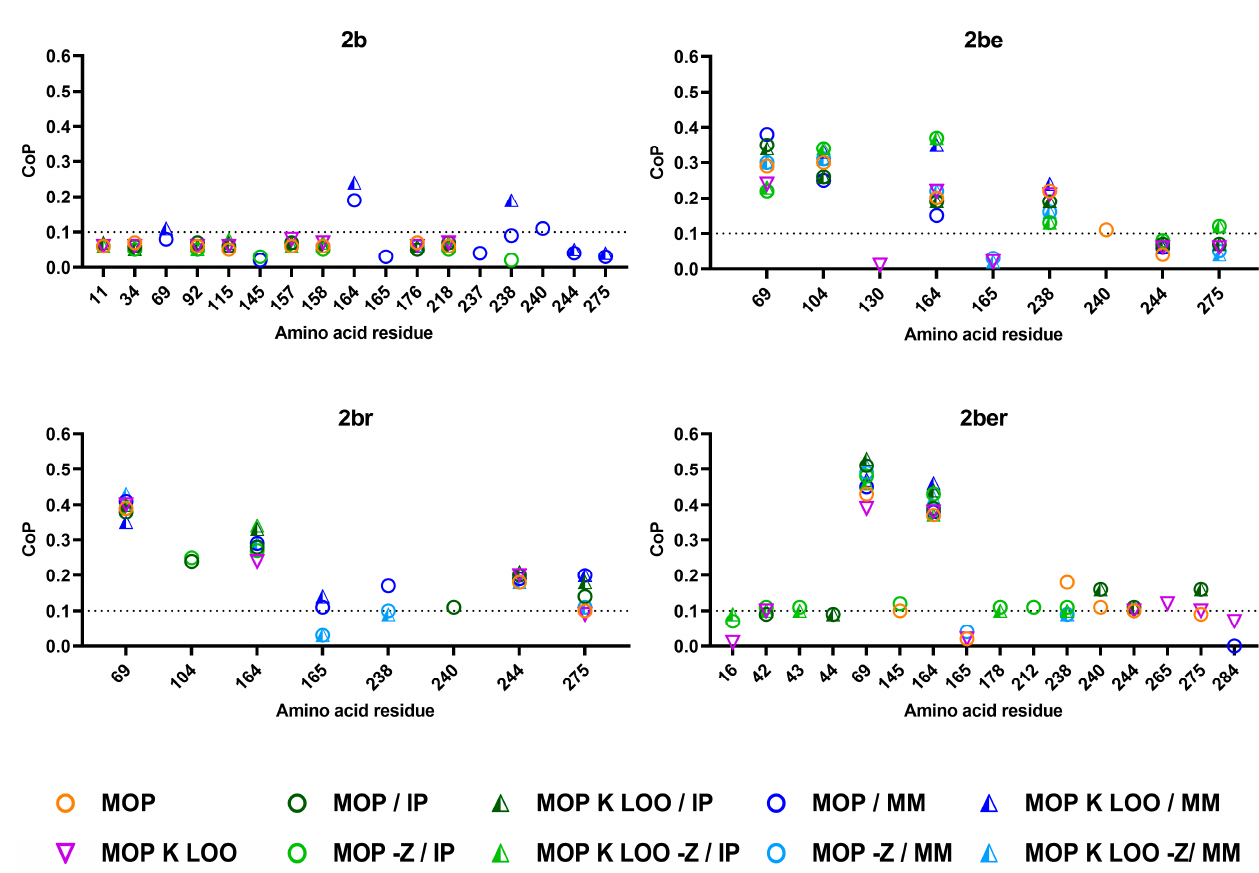
Figure 1. CoP values determined by OptiSLang for the PRAS positions (according to the Ambler nomenclature) in TEM- variants determined by different models. CoP = Coefficient of Prognosis, MOP = Metamodel of Optimal Prognosis, K = kriging regression, LOO = leave one out, − Z = excluding missing amino acid residues (set at zero), IP = including isoelectric point of the amino acid residues, MM = including the molecular mass of the amino acid residues.